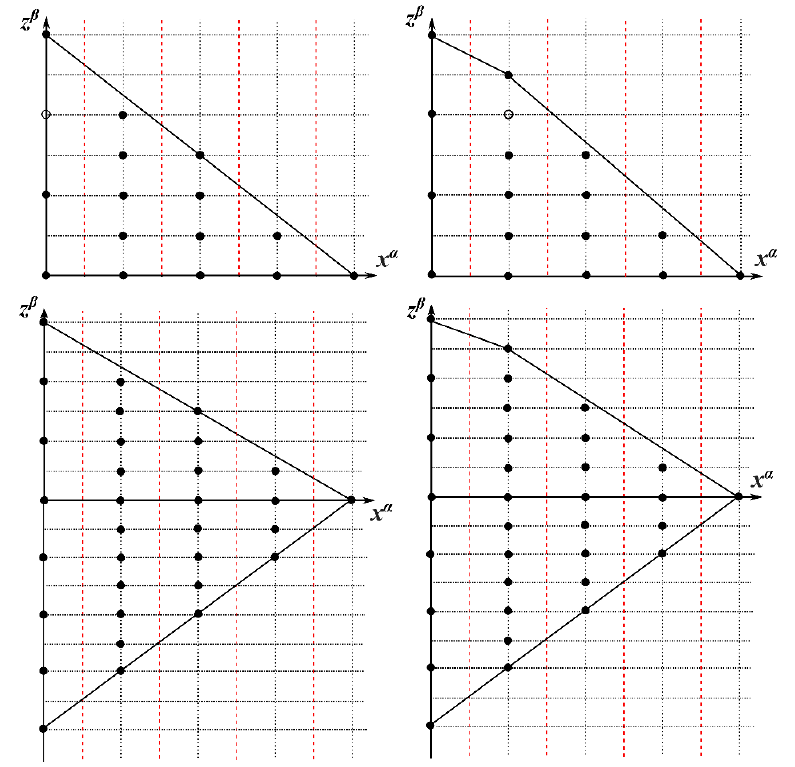
Figure 2 . A collection of Newton polygon for examples of SCFT with g = D N . Each black dot represents a monomial in SW curve in the form of x (cid:11) z (cid:12) ; except that for the x 0 axis, each term represents the Pfa(cid:14)an ~ (cid:30) , so we shall read it as are omitted. The upper left diagram gives D (4) D (6) [5]. The two lower diagrams represent the same irregular puncture, but with an additional 4 regular puncture (e.g. maximal) at south pole. We denote them as ( D (4) theory,